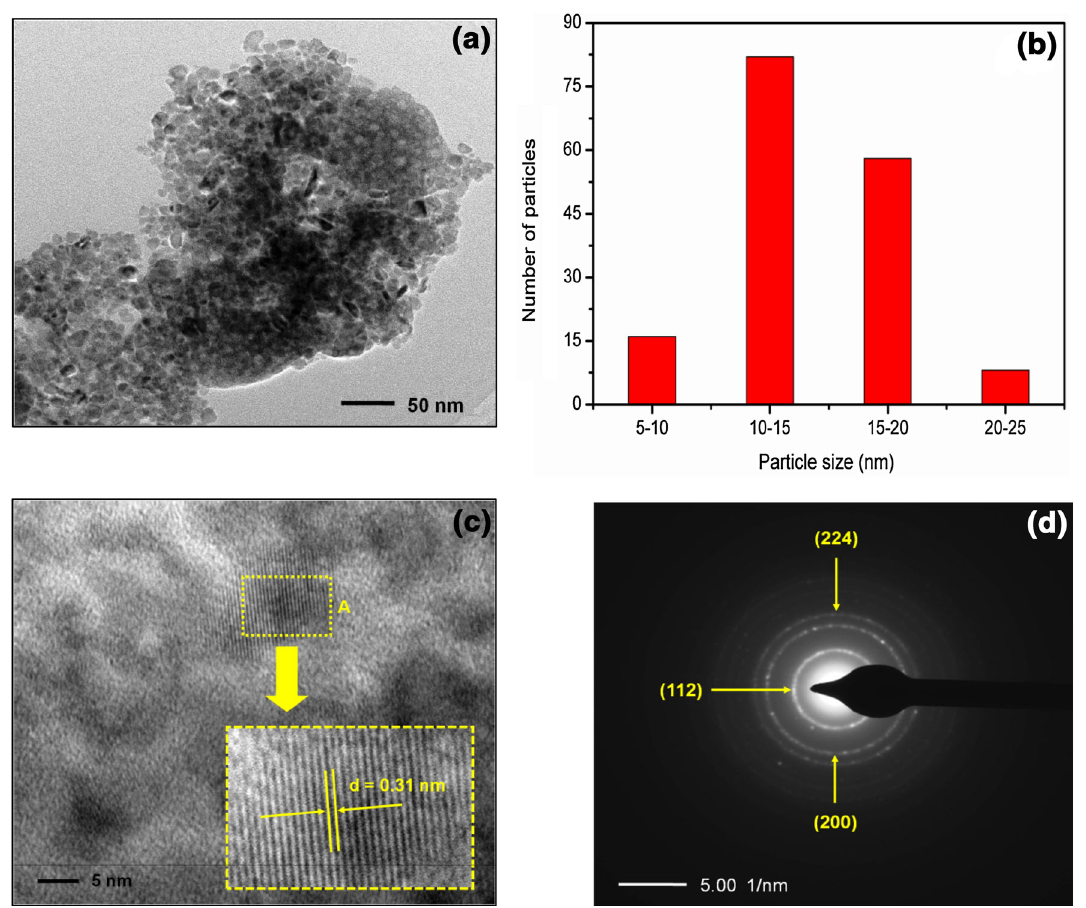
Fig. 4 a TEM image with low magnification, b particle size distribution histogram, representing particle size ranging from 5 to 25 nm, c HR-TEM, demonstrating nanoparticles have lattice fringes